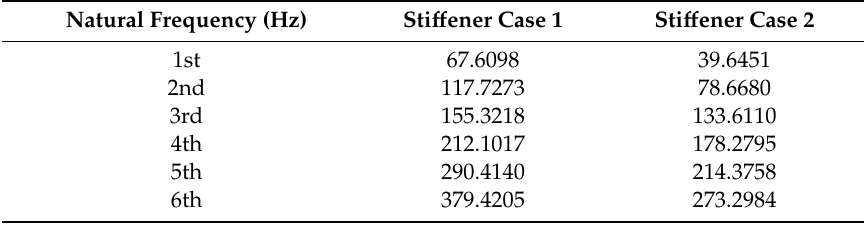
Table 3. Natural frequencies of different stiffener cases.